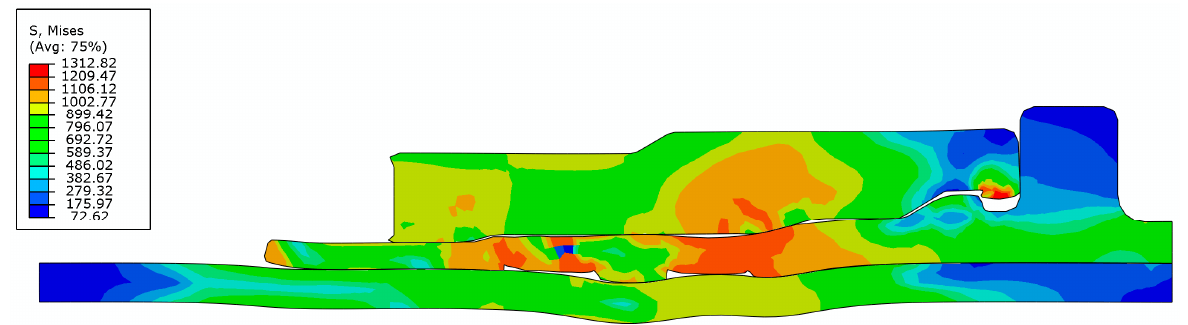
Figure 7. The von Mises stress distribution of axial extrusion joint after extrusion.